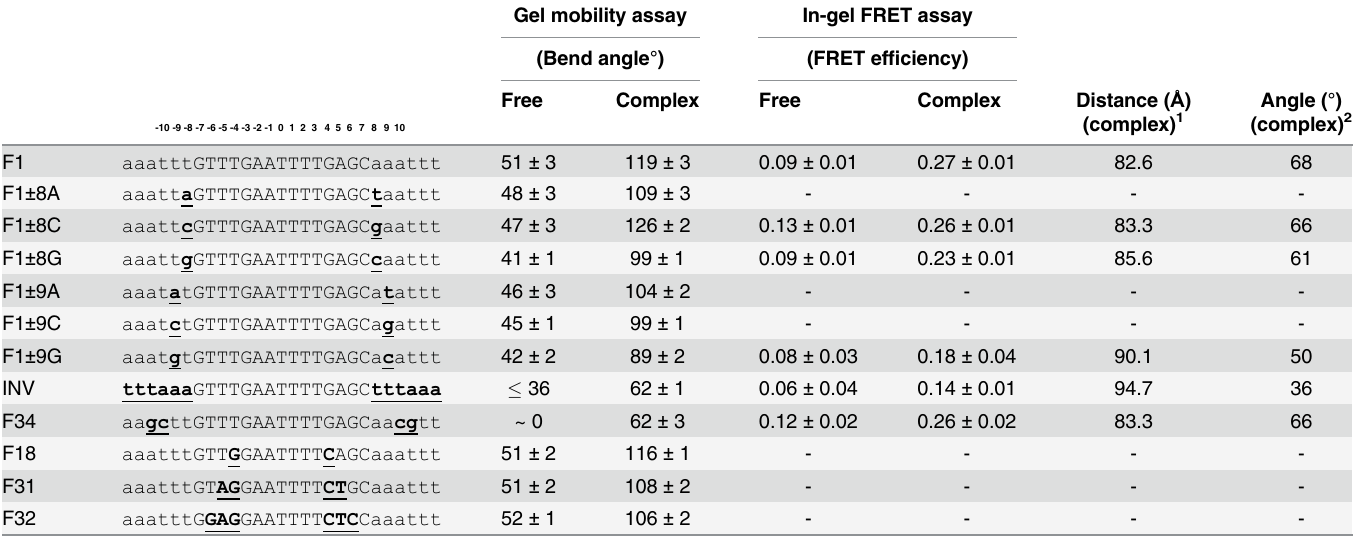
Table 4. Effects of flanking and core substitutions on Fis-induced DNA bending